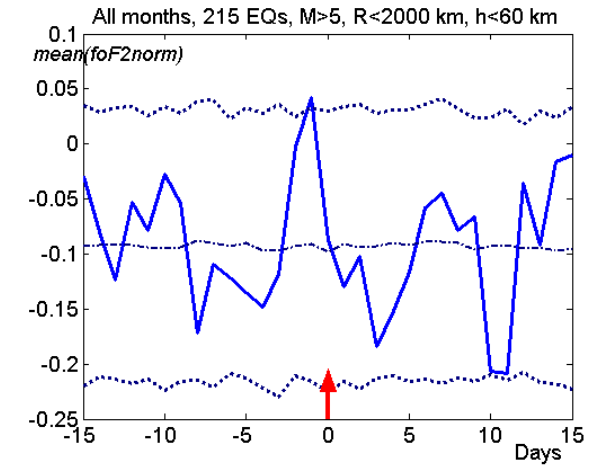
Fig. 7. Result of the superposition of epoches for foF 2 norm in case of the winter-earthquakes with M > 5 , R < 2000 km, and h < 60 km. The superposition time equals 30 days. The red arrow shows the day zero of the earthquakes. The mean value of foE norm ( i )